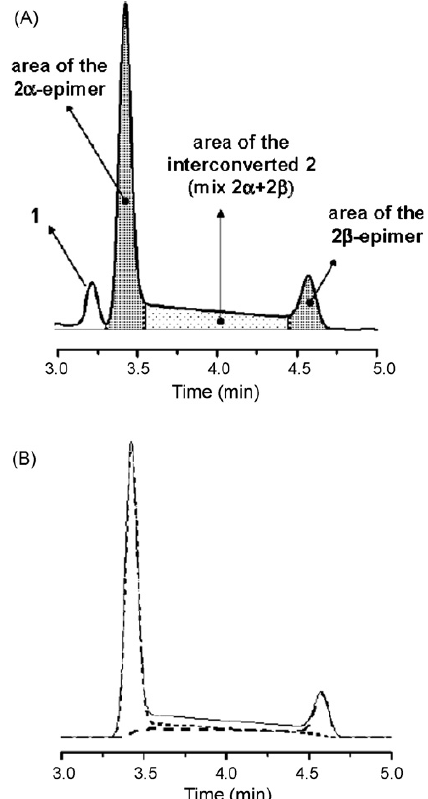
Figure 7. (A) Schematic representation of the integration mode used for the calculation of 2 α - and 2 β -epimers areas. (B) Computer simulated profiles of 2 α (dotted line), 2 β (dashed line), and of the mixture 2 α + 2 β (solid line). Reproduced from Figure 5 in Reference [41] with permission from Elsevier. Copyright